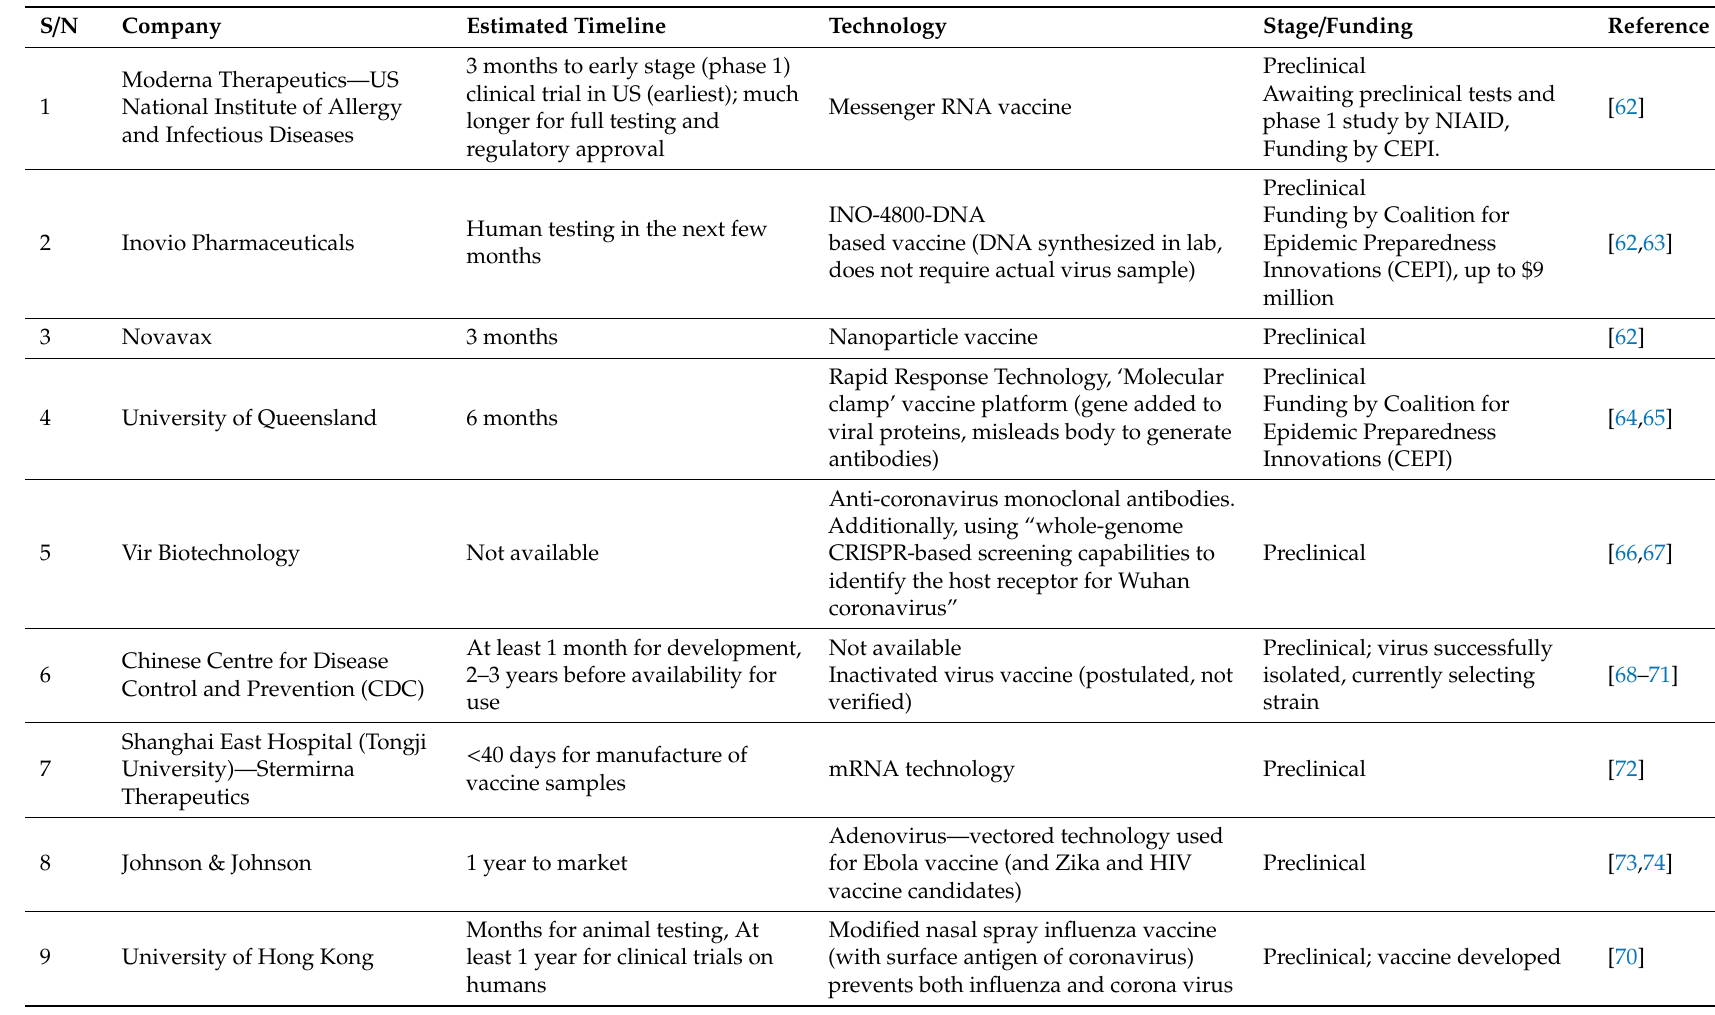
Table 3. Ongoing vaccine development for